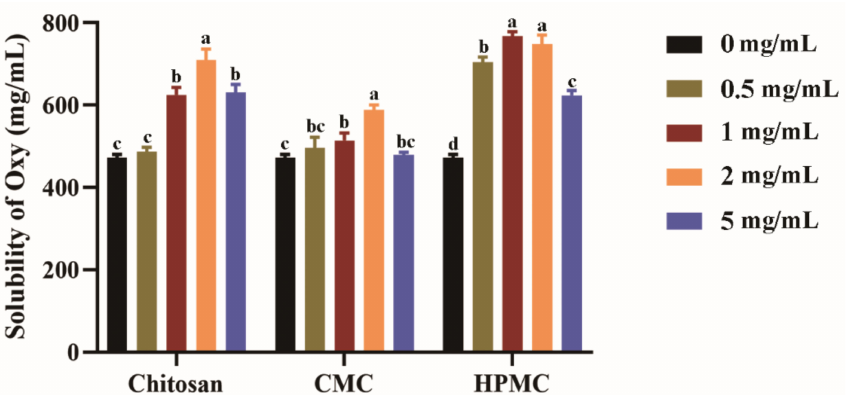
Figure 1. The effect of chitosan, carboxymethylcellulose (CMC), and hydroxypropyl methylcellulose (HPMC) on the solubility of Oxy in water at 20 ◦ C ( n = 3). Data were presented as mean ± SD, and sig- nificant differences among 0 mg/mL (no water-soluble polymer added) and different concentrations of polymer are shown with lower case letters a–d.